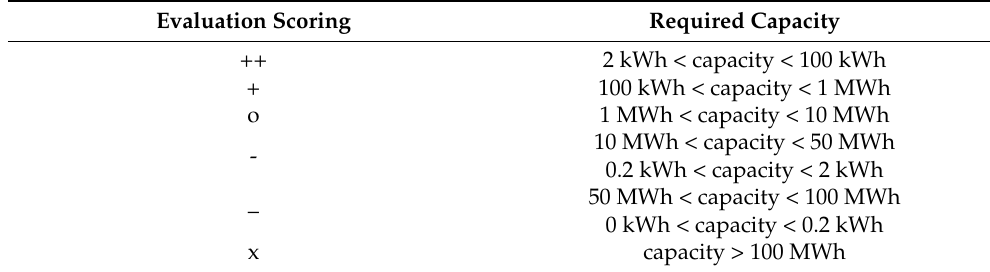
Table A3. Conversion table used for the required capacity.